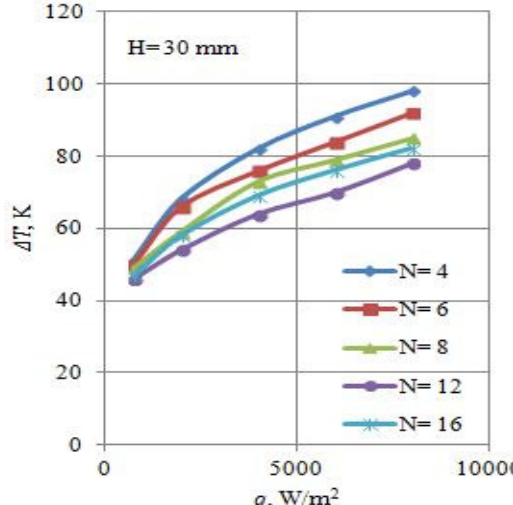
Fig. 5. Effect of fins number on the and surface heat flux for the interrupted differencedifferencedifferencedifference longitudinal